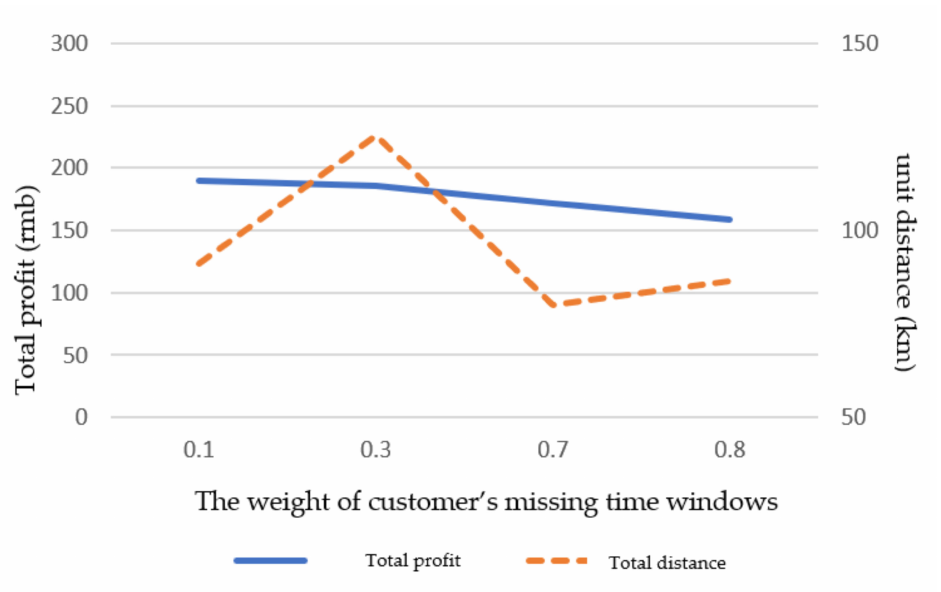
Figure 7. The result of the relationship between the weight of missed time windows and the profit and total route distance under a fixed shortest route weight.